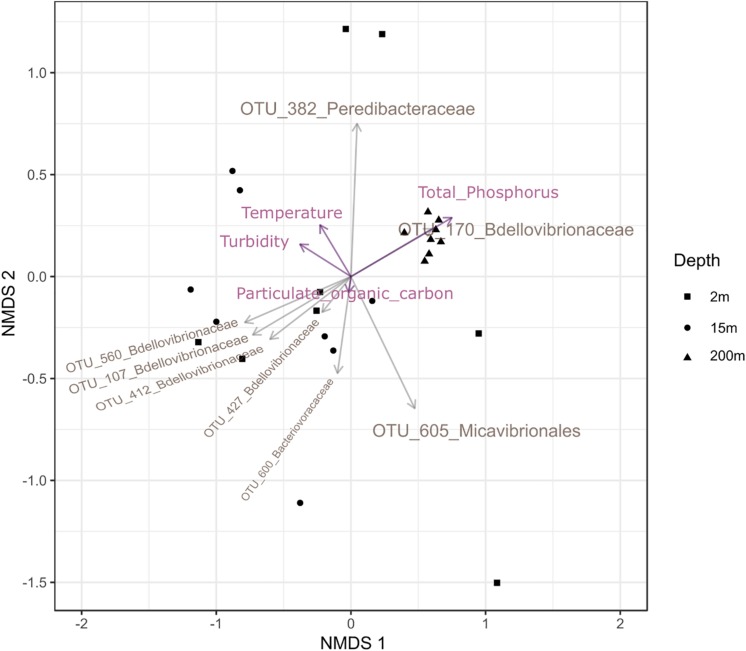
Custom NMDS (stress < 0.2) for pt4-SHL2 site with the abiotic descriptors.